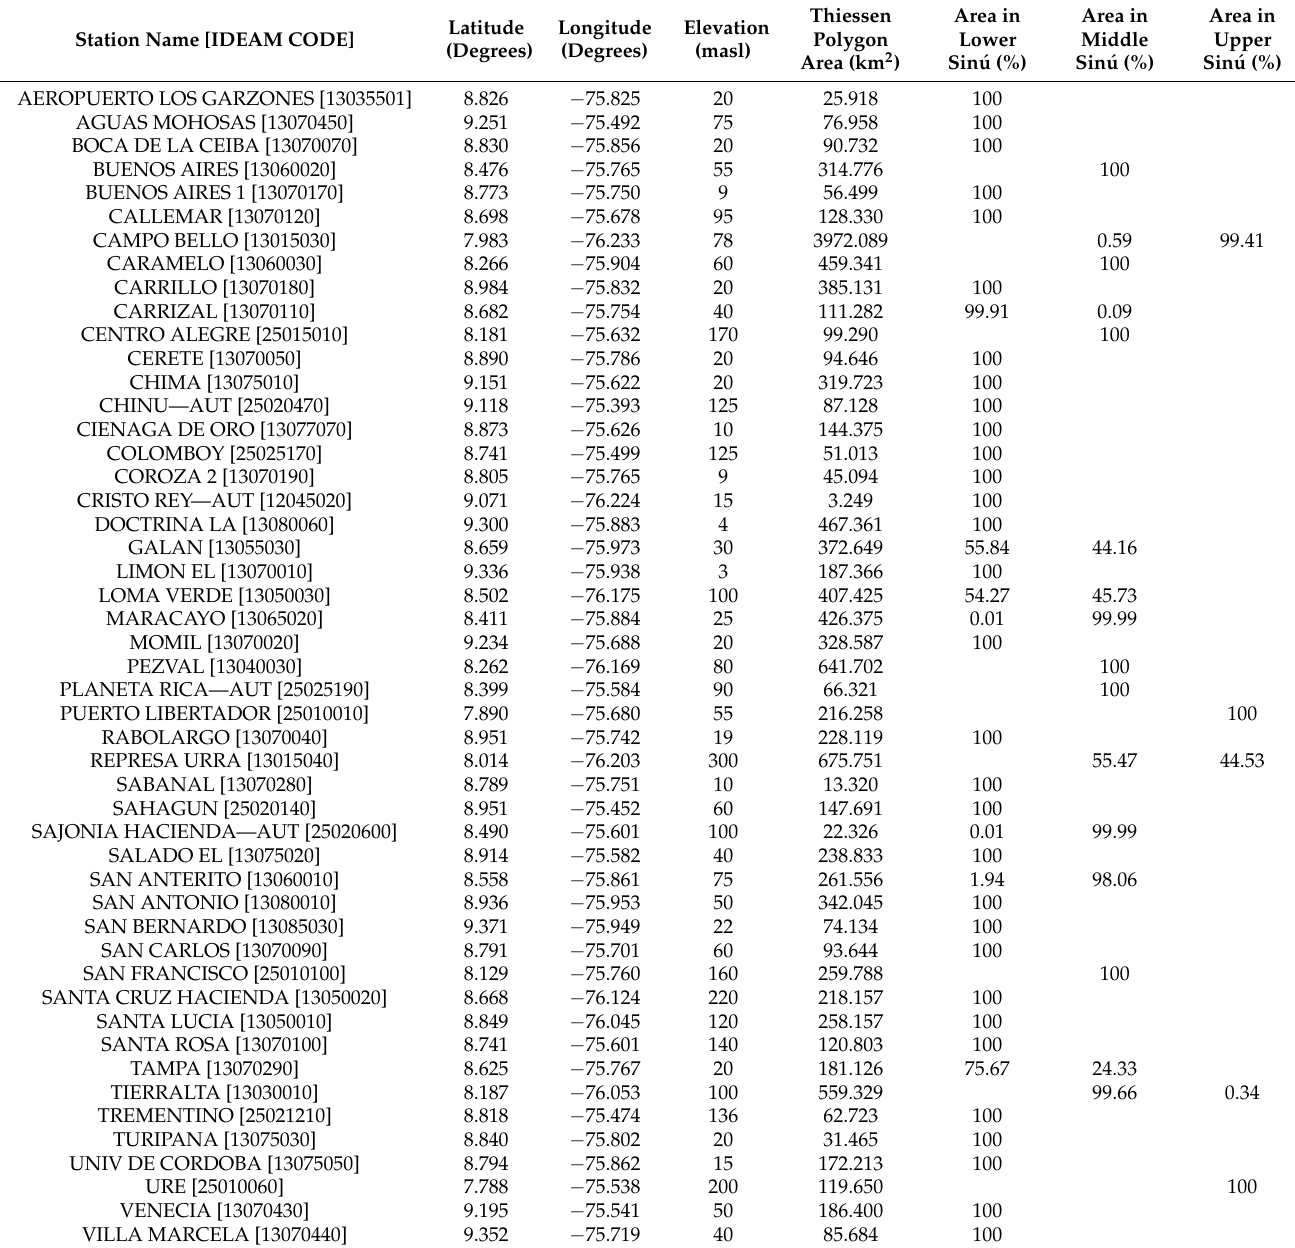
Table A1. Characteristics of the IDEAM’s hydrometeorological stations employed for validating reanalysis datasets in the Sin ú River basin. The elevation is given in meters above sea level (masl). Stations that include the suffix Aut signify automatically recording